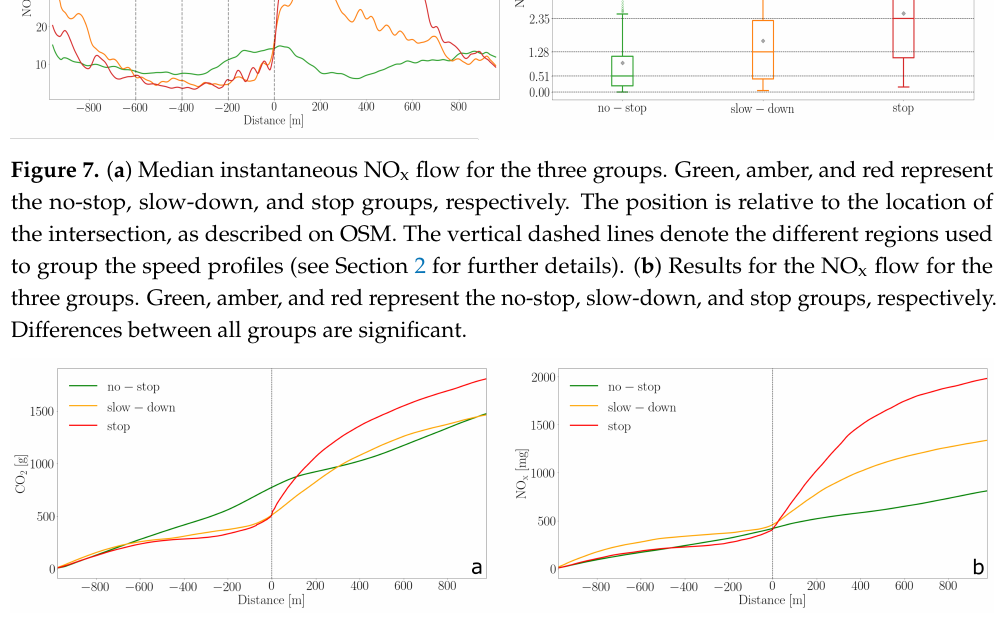
Figure 8. Cumulative flows for the three groups. Green, amber, and red represent the no-stop, slow-down, and stop groups, respectively. The position is relative to the location of the intersection as described in OSM. The vertical dashed line denotes the location of the intersection. ( a ) Results for the CO 2 flow for the three groups; ( b ) Results for NO x for the three groups.